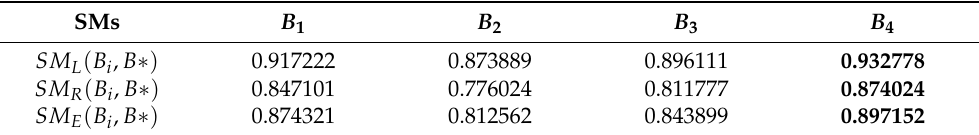
Table 6. Similarity values of B ∗ and B i ( i = 1,2,3,4 )